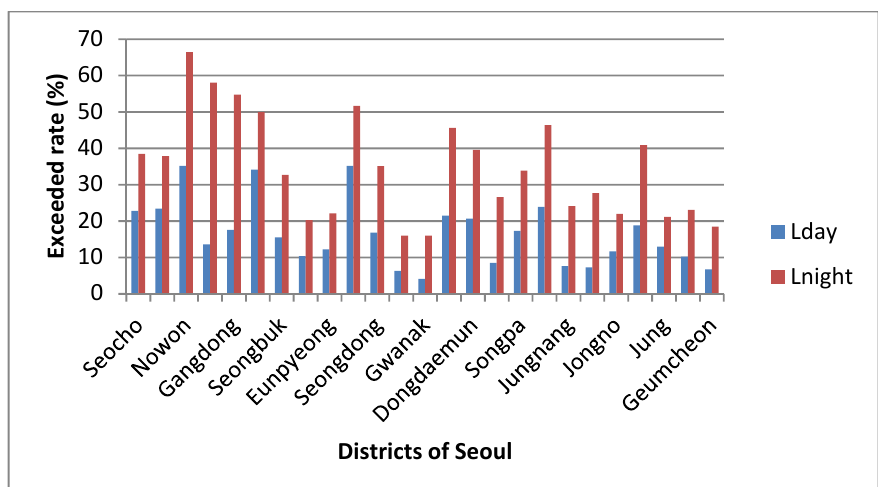
Figure 6. Percentage of exposed population exceeding the standard by